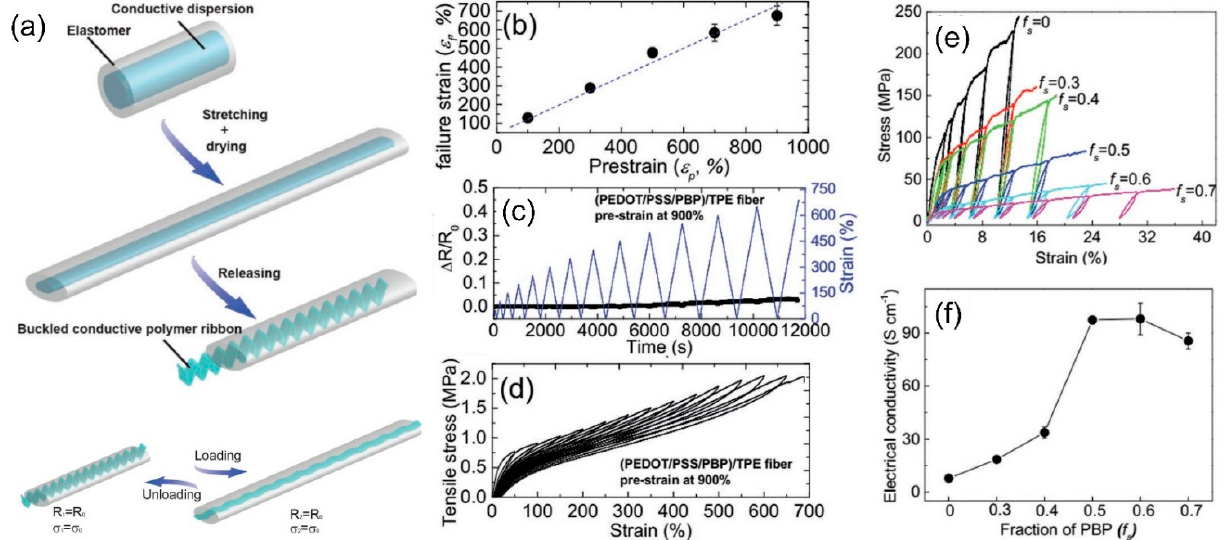
Figure 5. ( a ) Schematic illustration of pre-stretch-buckling strategy to obtain buckled conductive polymer micro-ribbons in TPE; ( b ) maximum failure strain versus different fabrication pre-strain of fibers; ( c ) relative resistance change under incremental loading and unloading cycles at 900% pre-strain and corresponding ( d ) stress–strain curves; ( e ) stress–strain curve and ( f ) conductivity of PEDOT:PSS/PBP films with different PBP volume fraction during incremental loading and unloading cycles Reprinted with permission from Ref. [76]. 2019, Wiley-WCH. Table 1. Brief summary of the microstructures and corresponding electrical performance of conduc- tive